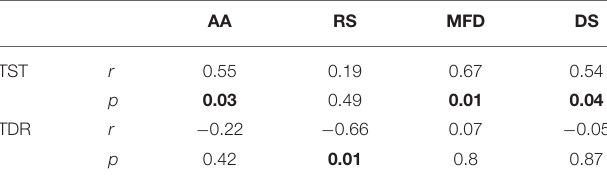
TABLE 3 | Perseverative errors (PE) in the WaLCT ADHD-C vs. TD. TABLE 4 | Significant zero-order correlations between ADHD-C’s performances on WalCT and NEPSY II and on WalCT and WISC-IV. Actual Expected Adjusted AA RS MFD DS residual* TST r 0.55